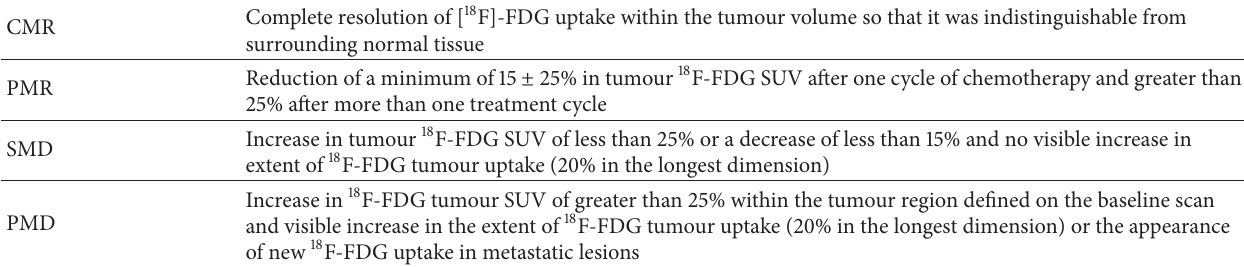
Table 1: EORTC response criteria for 18 F-FDG